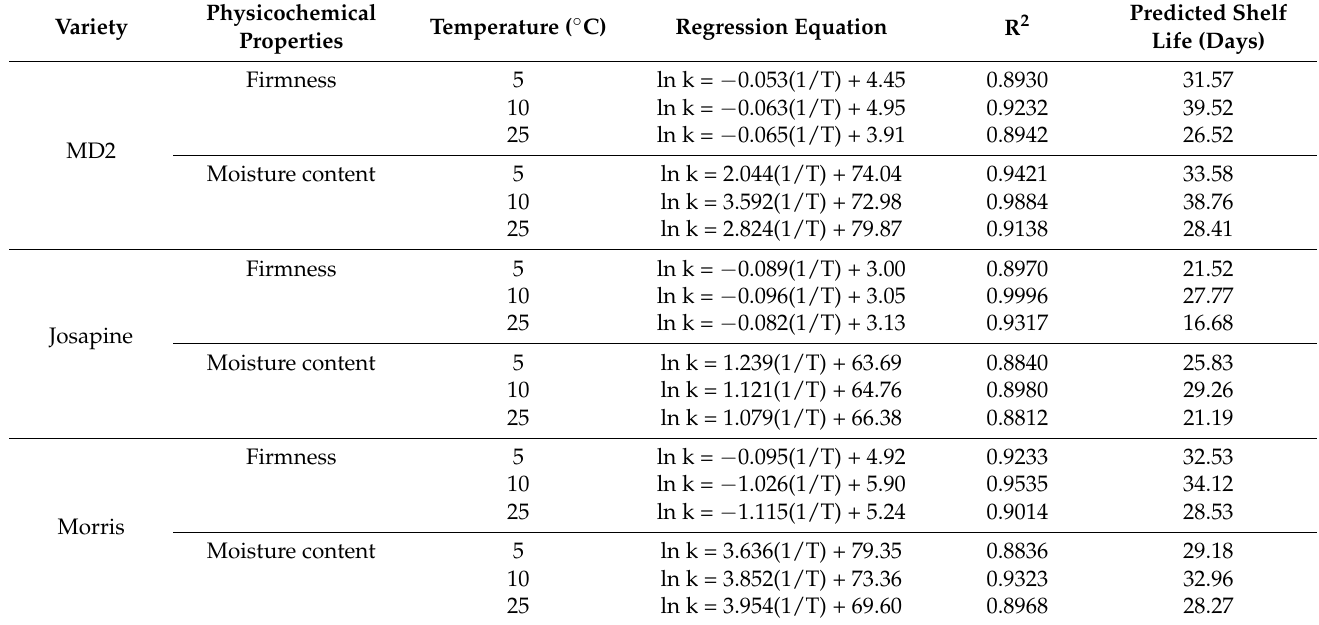
Table 6. Shelf life prediction of pineapples using regression equation at different storage temperatures in relation to the changes in firmness and moisture